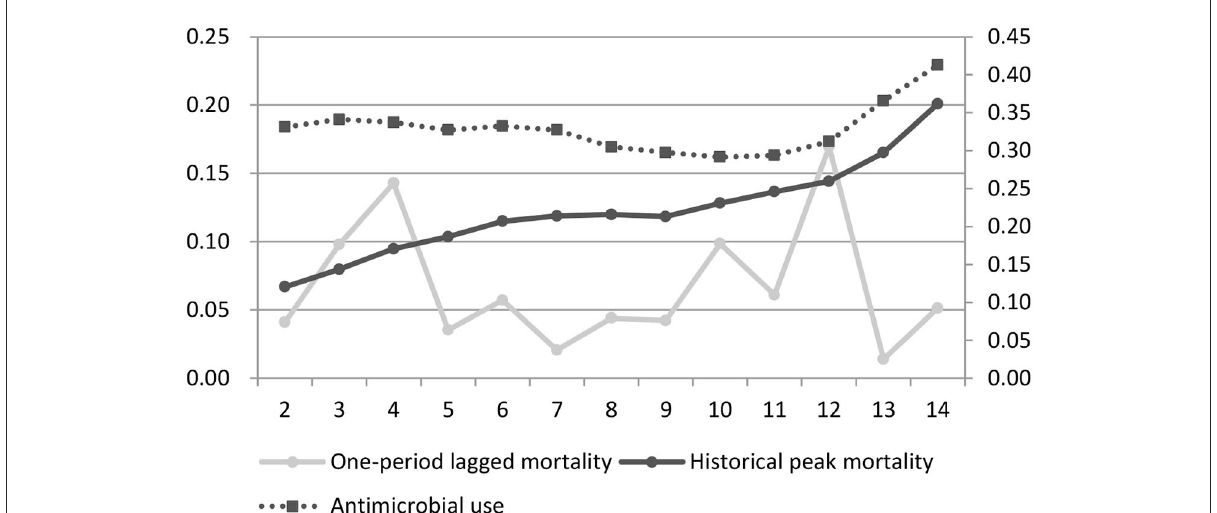
FIGURE1 Broiler mortality and current antibiotic use among the sample farmers. The horizontal axis represents batches of broilers, the left vertical axis represents the mortality, and the right vertical axis represents the cost of antibiotics per broiler (yuan/broiler).